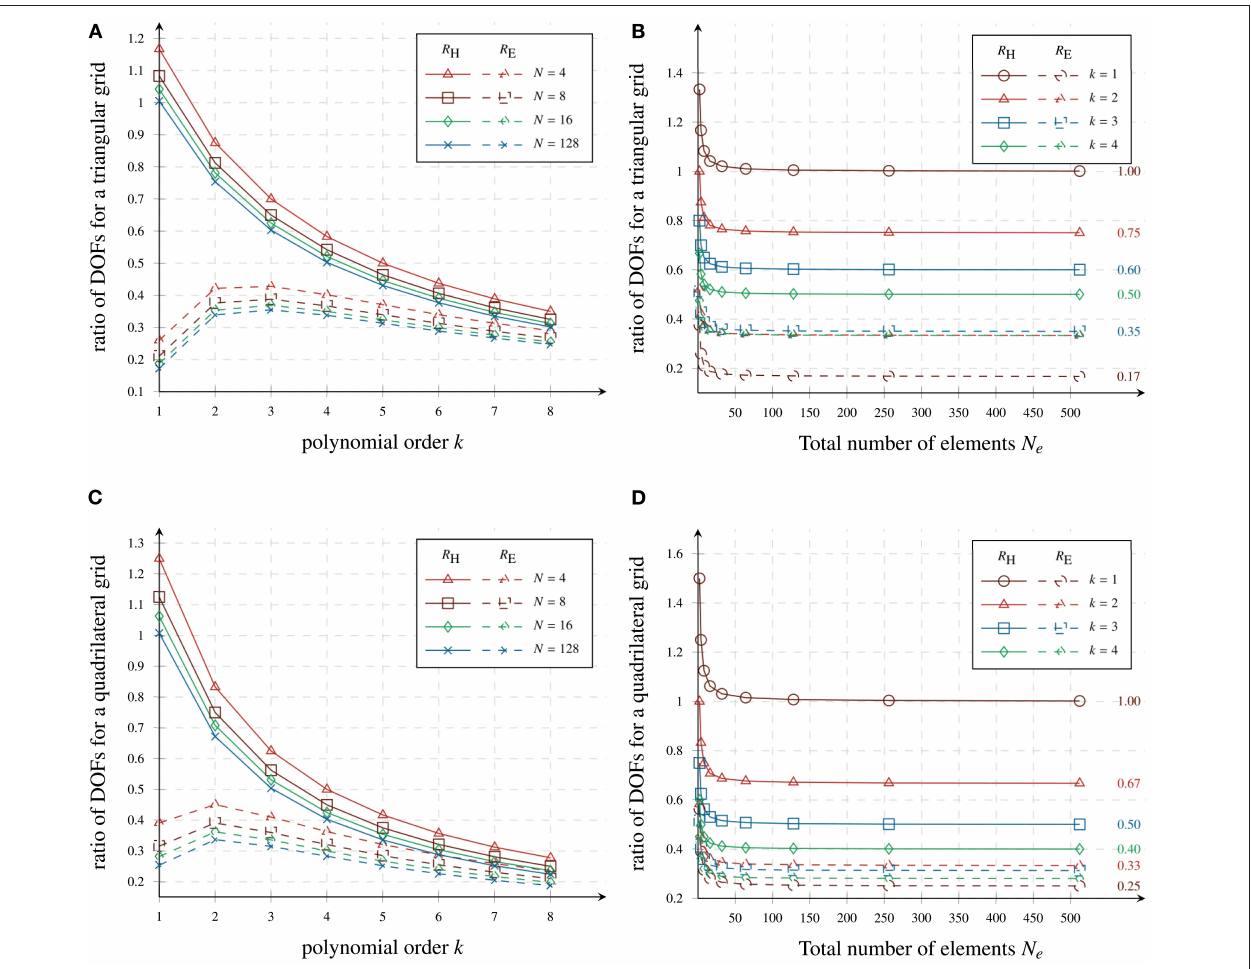
FIGURE 2 | Total degrees of freedom of the Weighted-IP compared to Hybridized- and Embedded-IP methods for both uniform triangular (A,B) and rectangular (C,D)